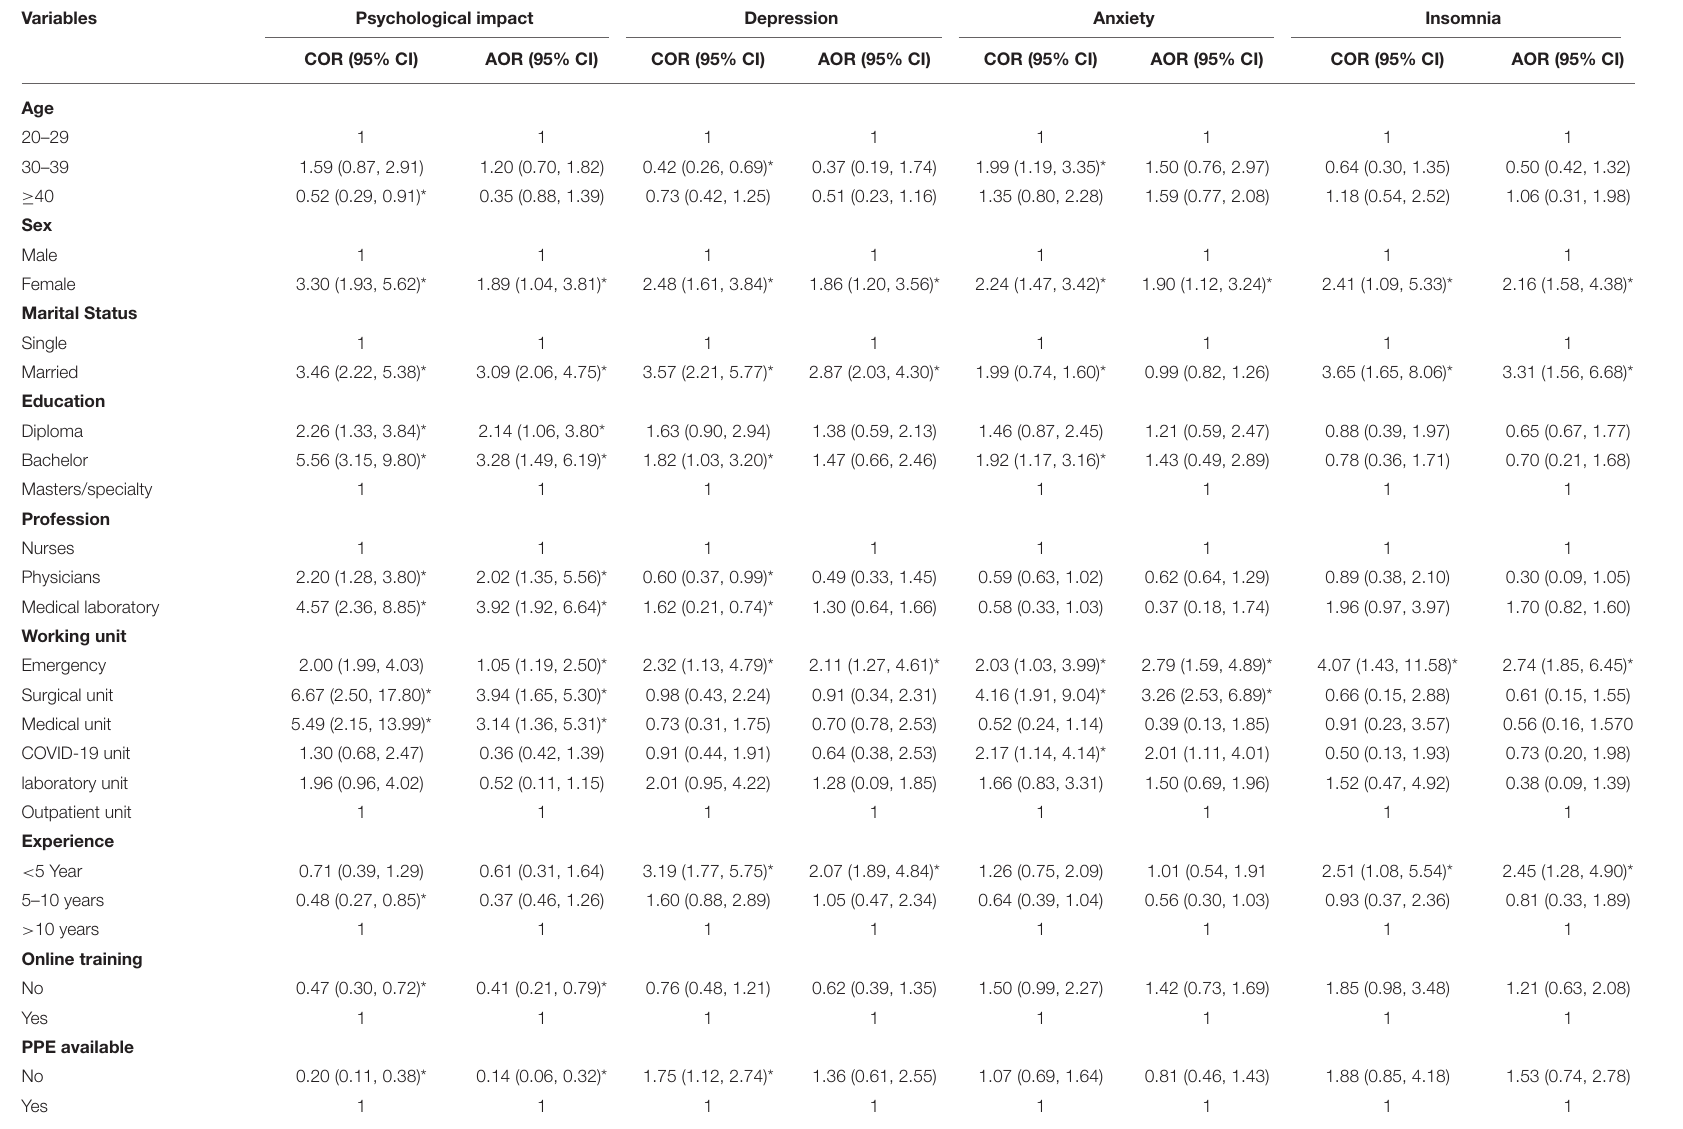
TABLE 5 | Factors associated with psychological distress, depression, anxiety, and insomnia during the COVID-19 pandemic among HCWs in North Shoa Zone health care facilities, Oromiya region, Ethiopia, July 2020 ( n = 417). Variables Psychological impact Depression Anxiety